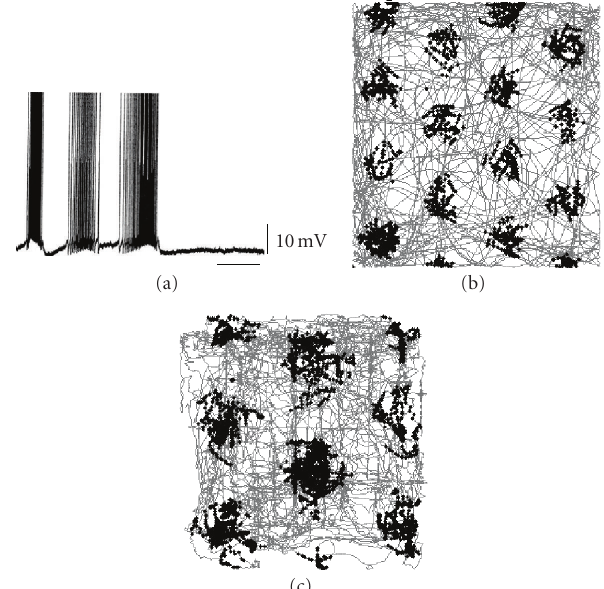
Figure 1: (a) Example of persistent firing in layer II pyramidal cell showing alternating cycles of spiking and nonspiking in data from Klink and Alonso [5]. (b) Simulation of grid cell firing dependent upon cyclical persistent spiking gated by random movement in a two-meter square environment. Spiking shown as black dots on trajectory in gray. (c) Simulation from same model using rat trajectory from experimental data in an 85 cm square environment.